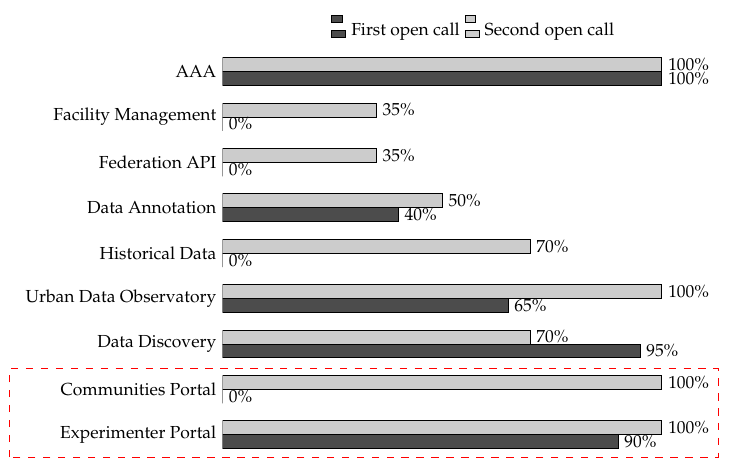
Figure 8. OrganiCity service adoption level during the first and second open